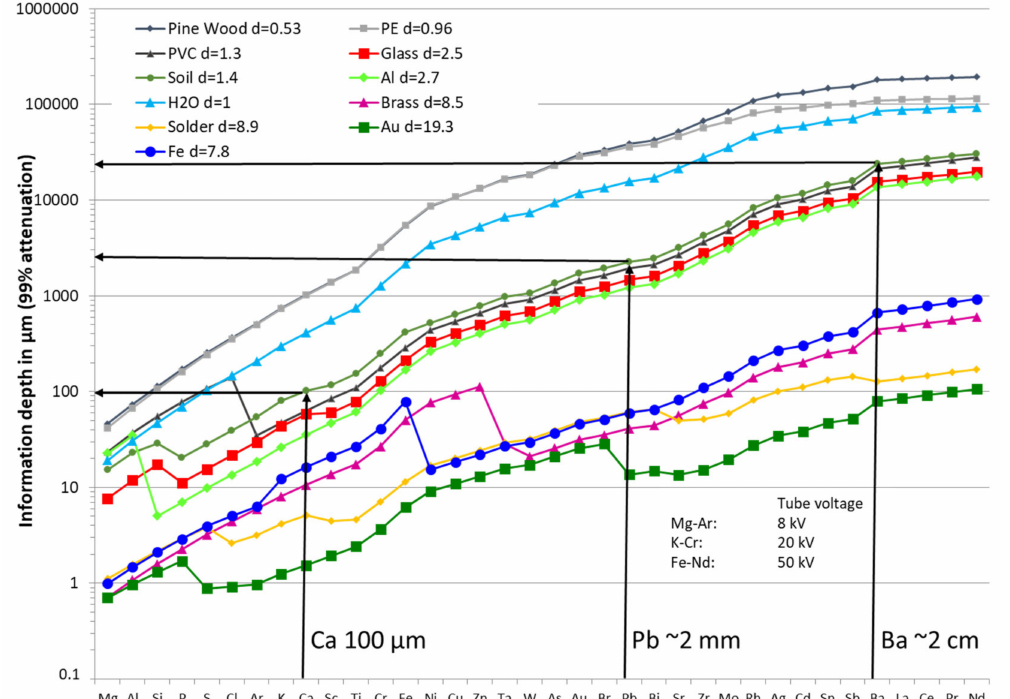
Figure 17. Information depth for a Thermo Niton XL3t spectrometer, according to element. (Image courtesy Mathieu Bauer, Thermo